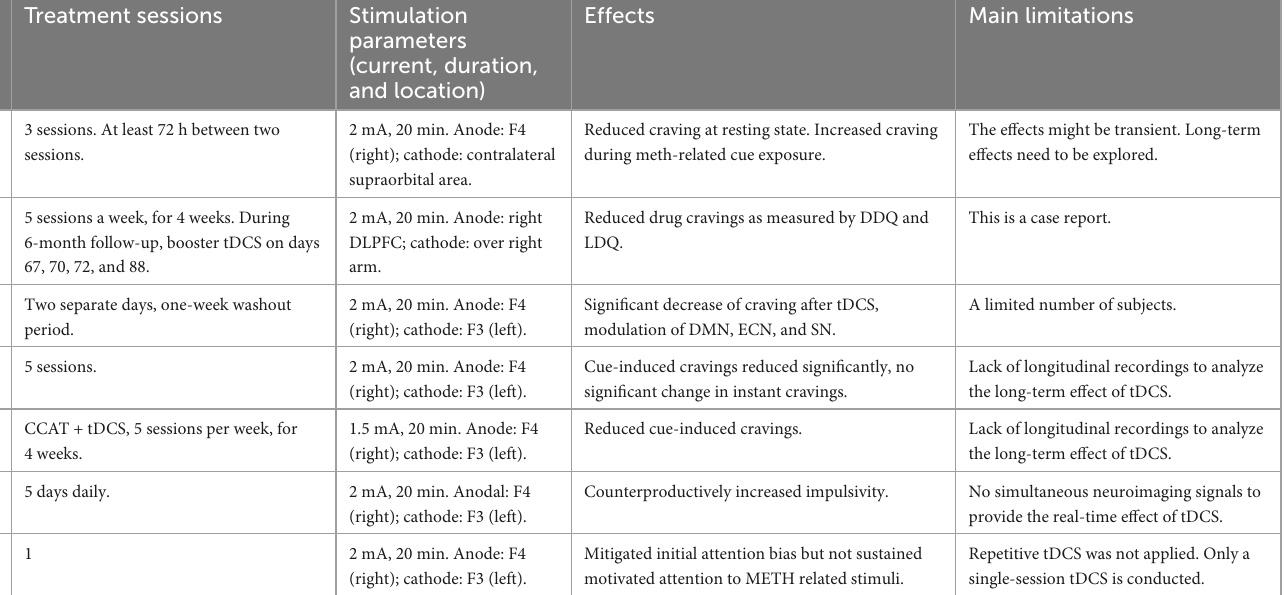
TABLE 4 Examples of tDCS treatments in patients with methamphetamine